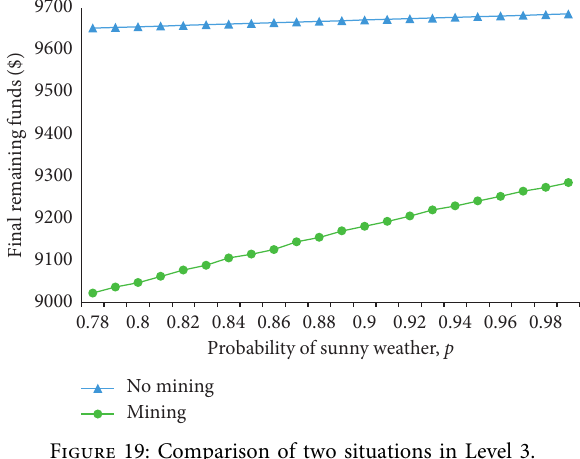
Figure 16: Comparison of remaining water.